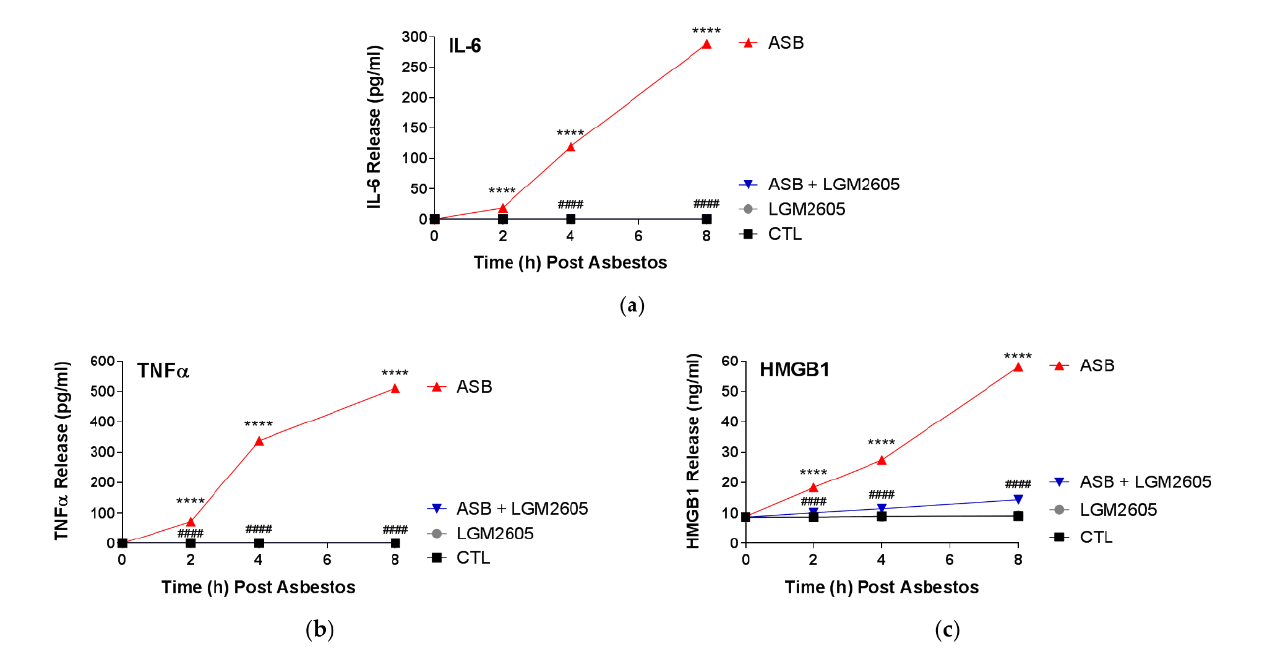
Figure 6. LGM2605 Inhibits Asbestos-Induced Proinflammatory Cytokine Release in Human Mesothelial Cells. Human pleural mesothelial cells were plated in a 6-well plate (1 × 10 6 cells/well) and exposed to 50 µM LGM2605 4 h prior to exposure to sterile crocidolite asbestos fibers (20 µg/cm 2 ). Release of IL-6 ( a ), TNF α ( b ), and HMGB1 ( c ) was determined at 0, 2, 4, and 8 h post asbestos exposure. Samples were run undiluted in triplicate and cytokine concentrations (pg/mL for IL-6 and TNF α , and ng/mL for HMGB1) are presented as mean ± SEM. * indicates a statistically significant difference ( p < 0.05) between ASB and CTL treated cells (**** p < 0.0001). # indicates a statistically